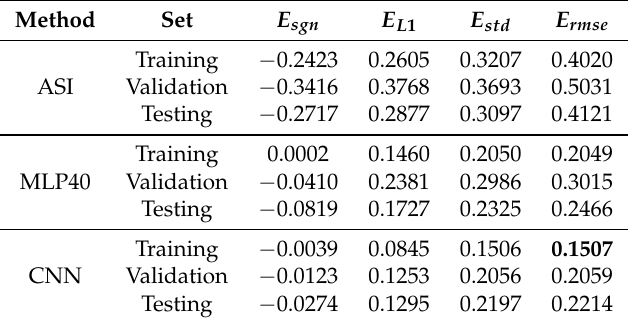
Table 4. Average error statistics across different methods for Gulf of Saint Lawrence